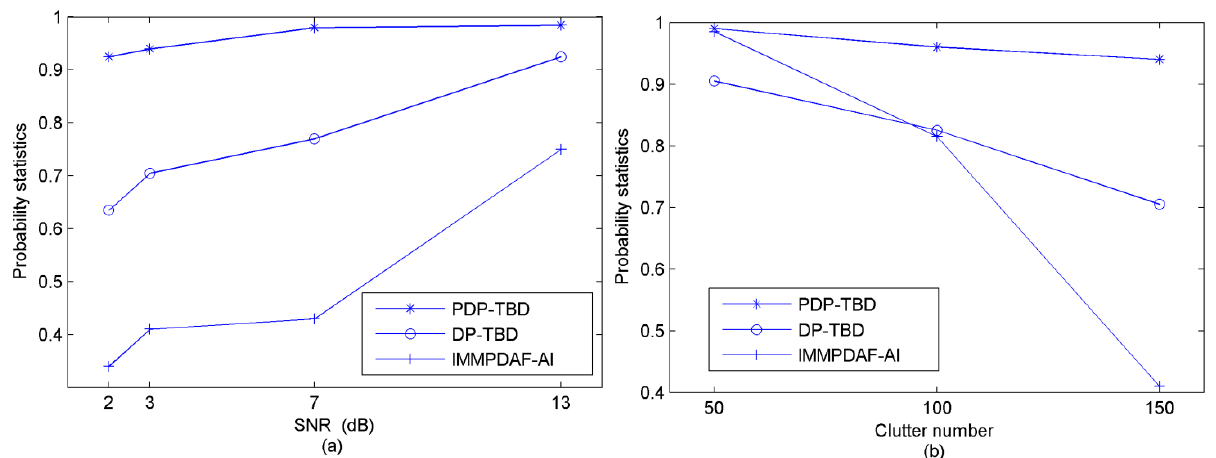
Figure 6. Comparison of the probabilities of correct target number estimation (200 runs, Scenario-1) ( a ) In different SNR environments ( λ = 150); ( b ) In different clutter number environments (SNR = 3 dB)